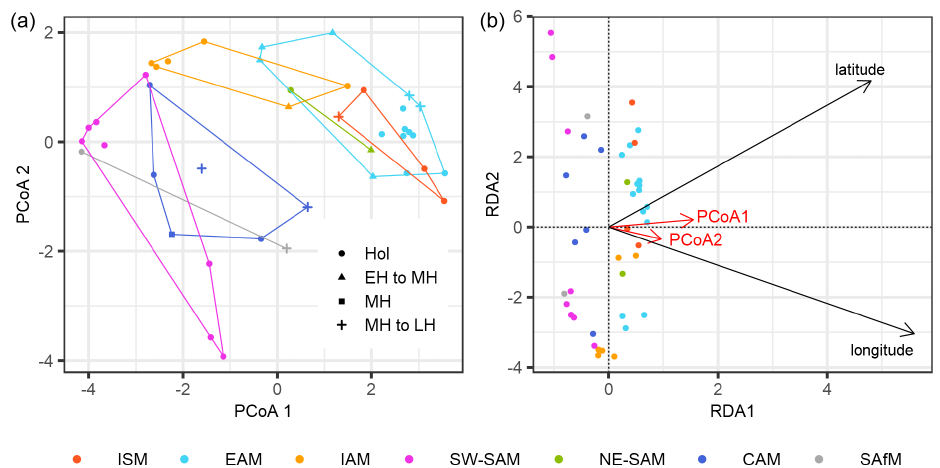
Figure 2. Results of the principal coordinate analysis (PCoA) and redundancy analysis (RDA). (a) PCoA biplot showing the loadings of each site on the first two axes, which represent 85% of the total variance. Shapes indicate the Holocene coverage of each site, where sites with a coverage ≥ 8000 years represent most or all of the Holocene (Hol). Sites with a temporal coverage of < 8000 years are coded to show whether they represent the early Holocene to mid-Holocene (EH to MH; record midpoint > 8000 years BP), the mid-Holocene (MH; record midpoint between 8000 and 5000 years BP) or the mid-Holocene to late Holocene (LH to MH; midpoint < 5000 years BP). (b) RDA triplot, where the response variables are the PCoa1 and PCoA2 axes explained by latitude and longitude. The direction of the PCoA axes have been fixed so that they align with the explanatory variables.